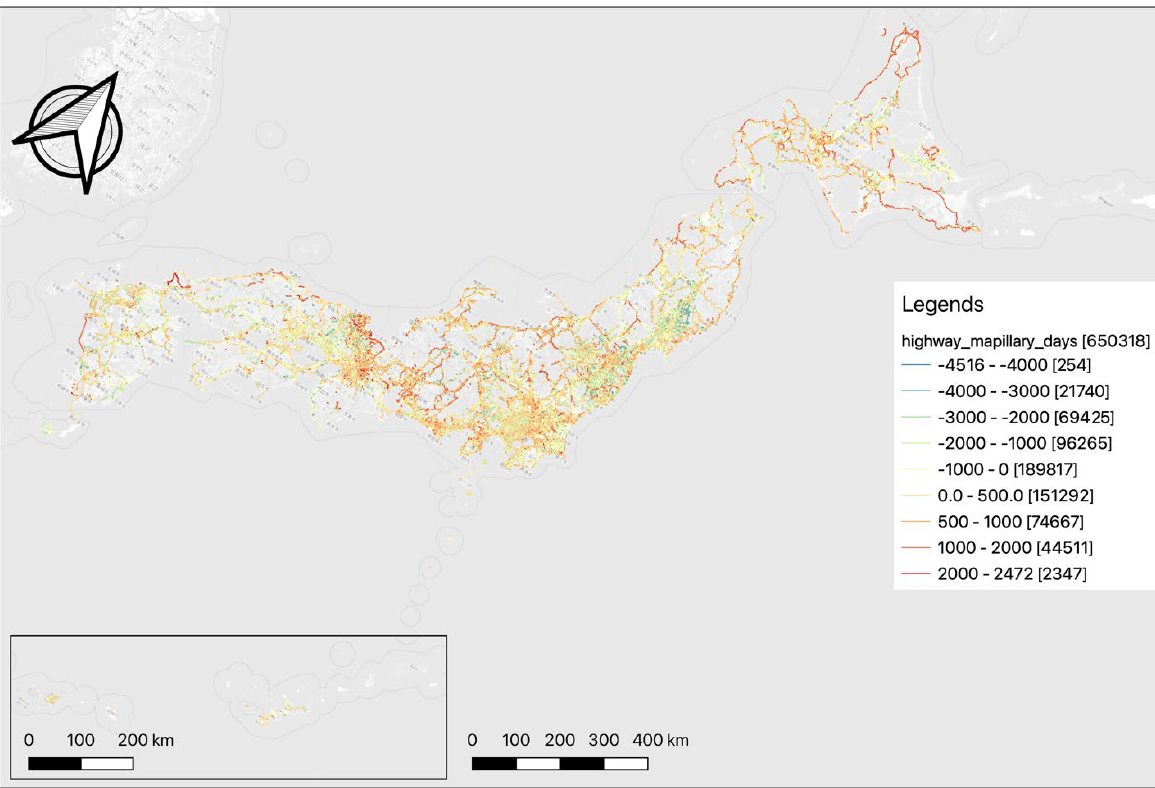
Figure 7. Last update date of OpenStreetMap road before and after Mapillary image taken (unit: